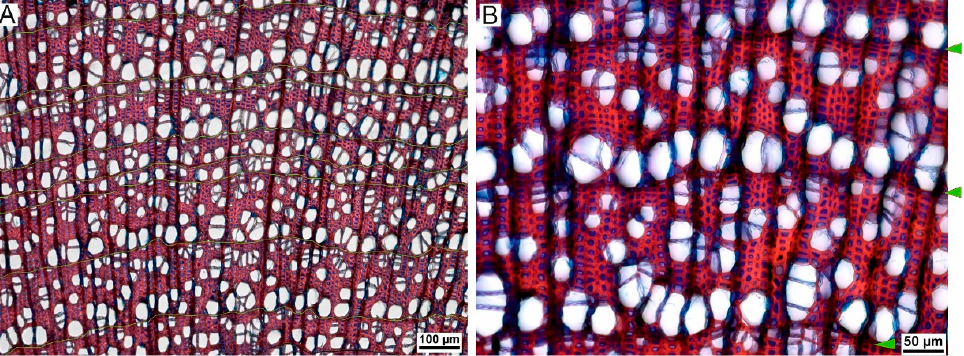
Figure 3. ( A ) Example of growth ring variations of Salix herbacea sampled; ( B ) detailed microscopic image showing distinct rings and semi-ring porous wood structure of S. herbacea .